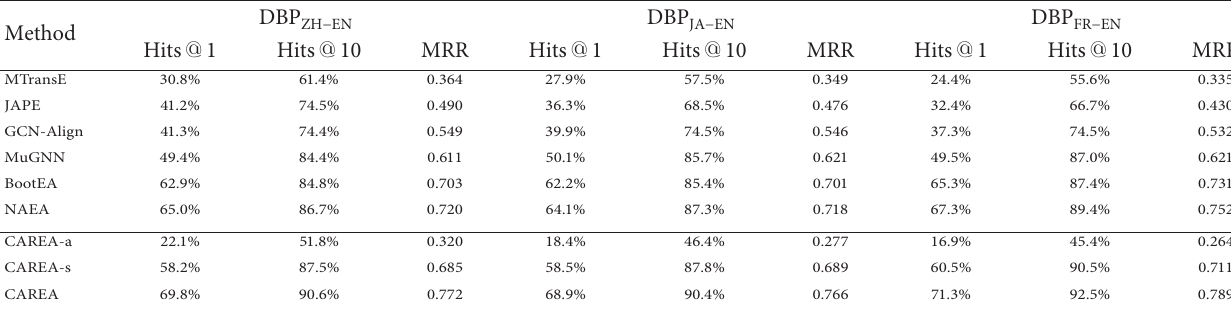
Table 2: Comparison with the baseline